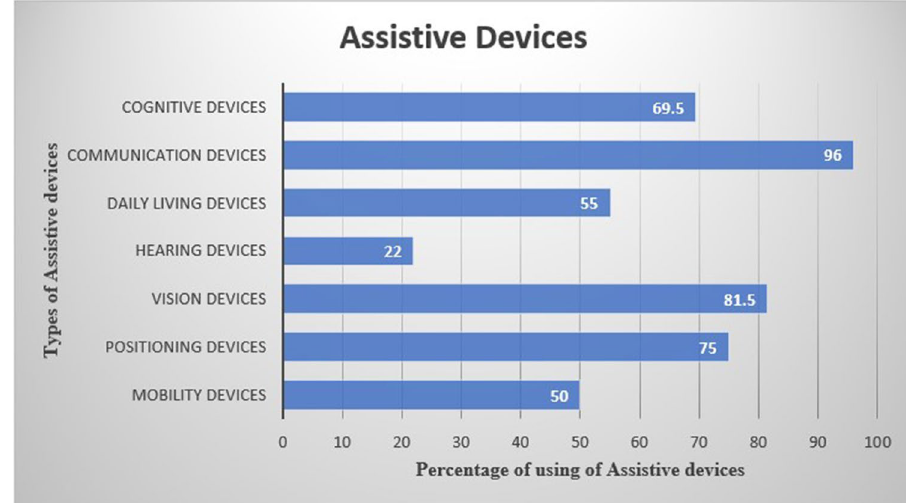
Fig. 1 Represented general uses of assistive devices